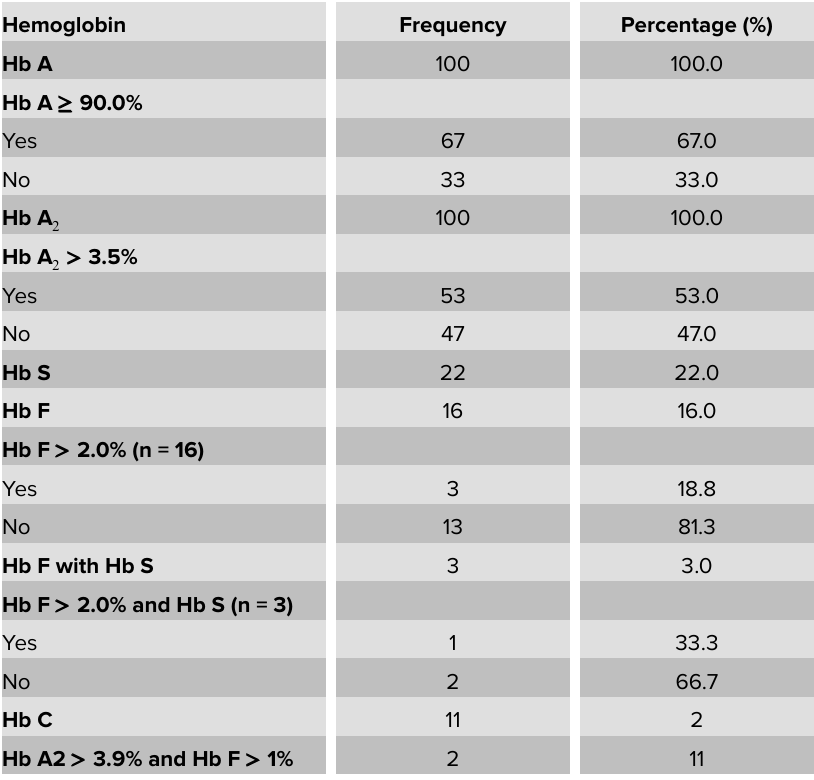
TABLE 3: Proportion of donors with normal and specific hemoglobin